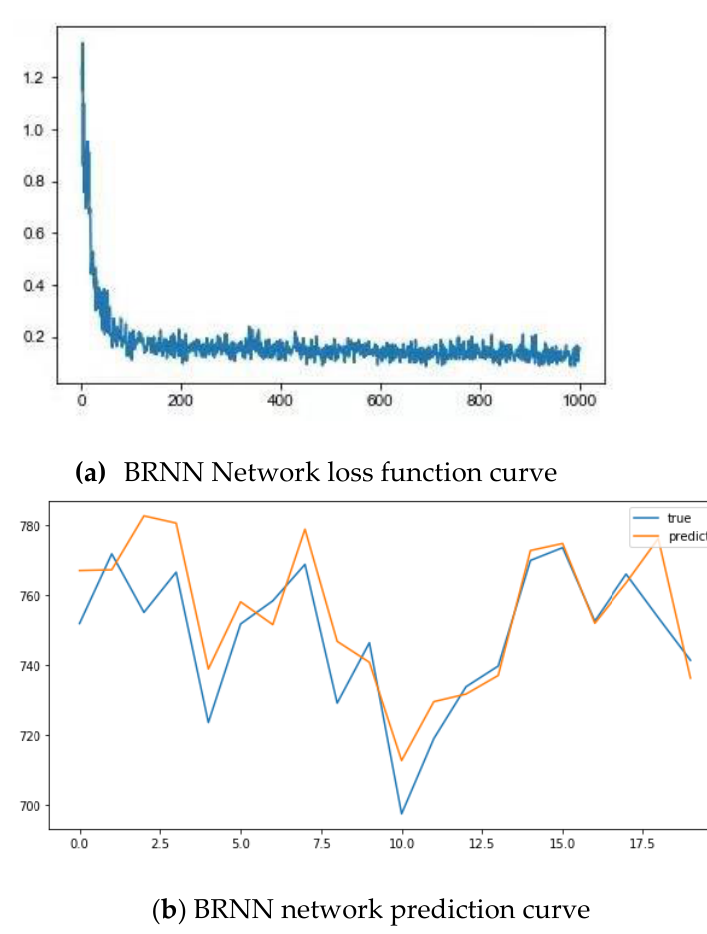
Figure 7. BRNN loss function curve and prediction results.